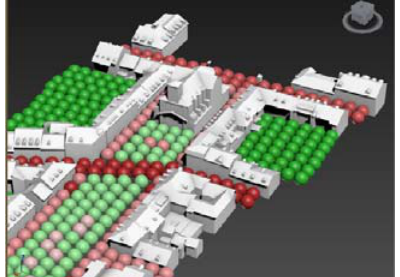
Figure 4. An air quality visualization technique